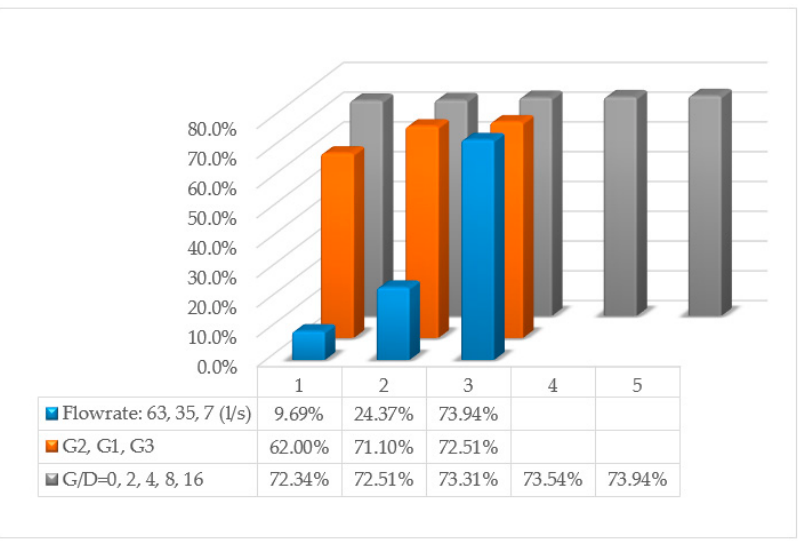
Figure 11. Sensitivity of each parameter to changes.